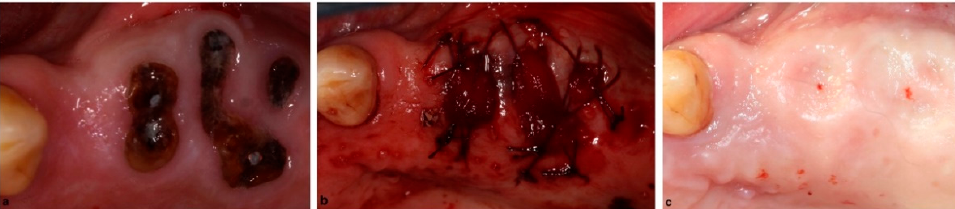
Figure 2. Alveolar ridge preservation with allogenic bone graft and collagen sponge: ( a ) extraction sites of posterior maxillary teeth, ( b ) bone graft placed into socket covered with collagen sponge, ( c ) extraction site healed with excellent keratinized gingival tissue with ideal dimensions preservation.